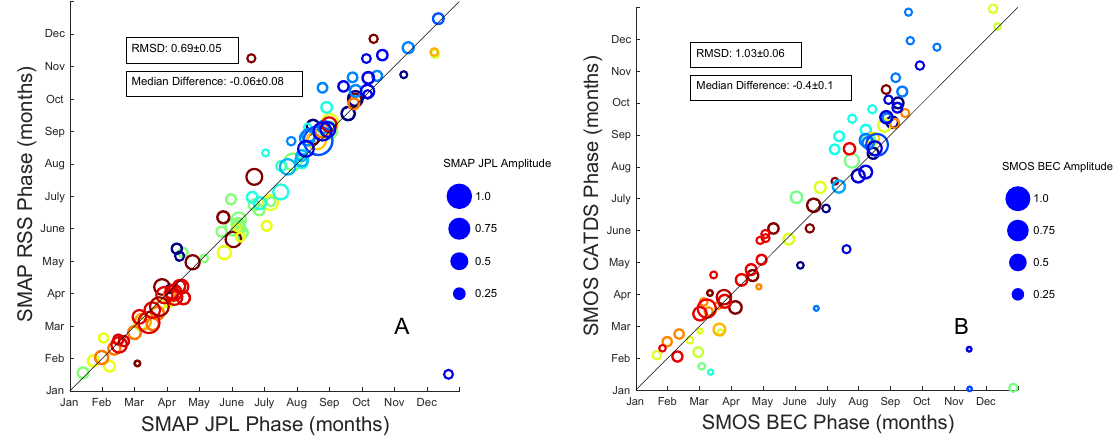
Figure 8. As in Figure 7. Comparisons are ( a ) SMAP RSS vs. SMAP JPL and ( b ) SMOS CATDS vs. SMOS BEC.